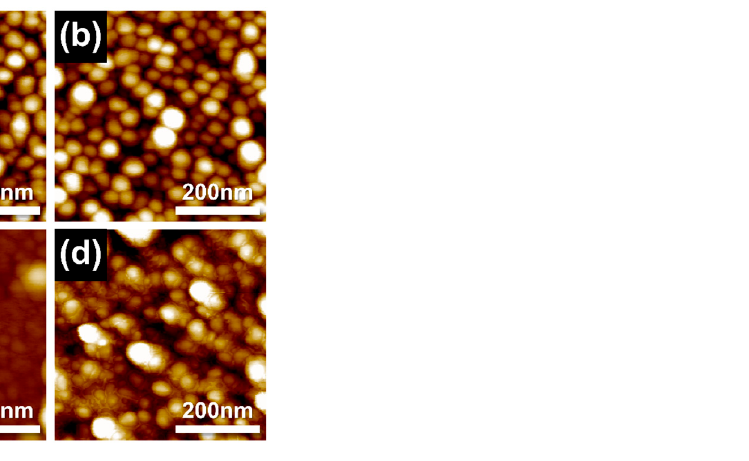
Figure 5. AFM topography of 100-nm-thick Ag-SDC cermet cathodes deposited under DC and RF powers of ( a ) Ag100-SDC50, ( b ) Ag60-SDC50, ( c ) Ag20-SDC50, and ( d ) Ag20-SDC80 on YSZ substrate.